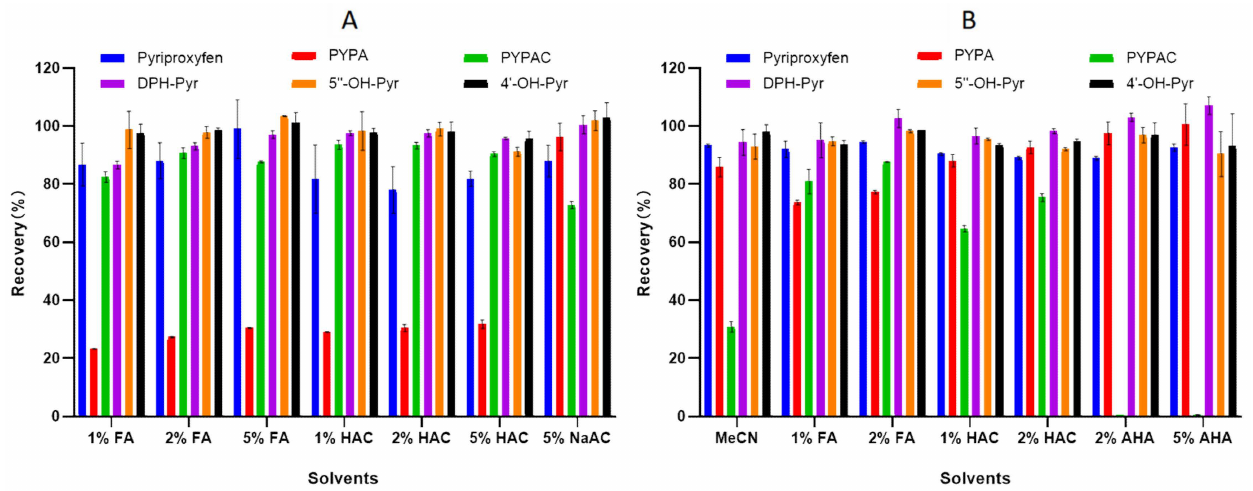
Figure 2. The recoveries of pyriproxyfen and its five metabolites in different soaking solvents ( A ) and different extraction solvents ( B